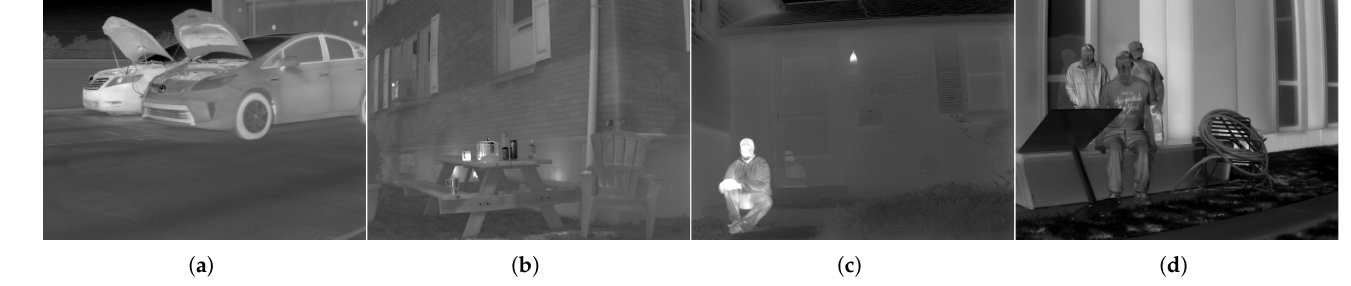
Figure 6. Test images selected from high-quality infrared image dataset [28]. Additional degradations are synthesized for the images according to the problems. ( a ) CARS; ( b ) COUNTRYARD; ( c ) HOUSE; ( d )